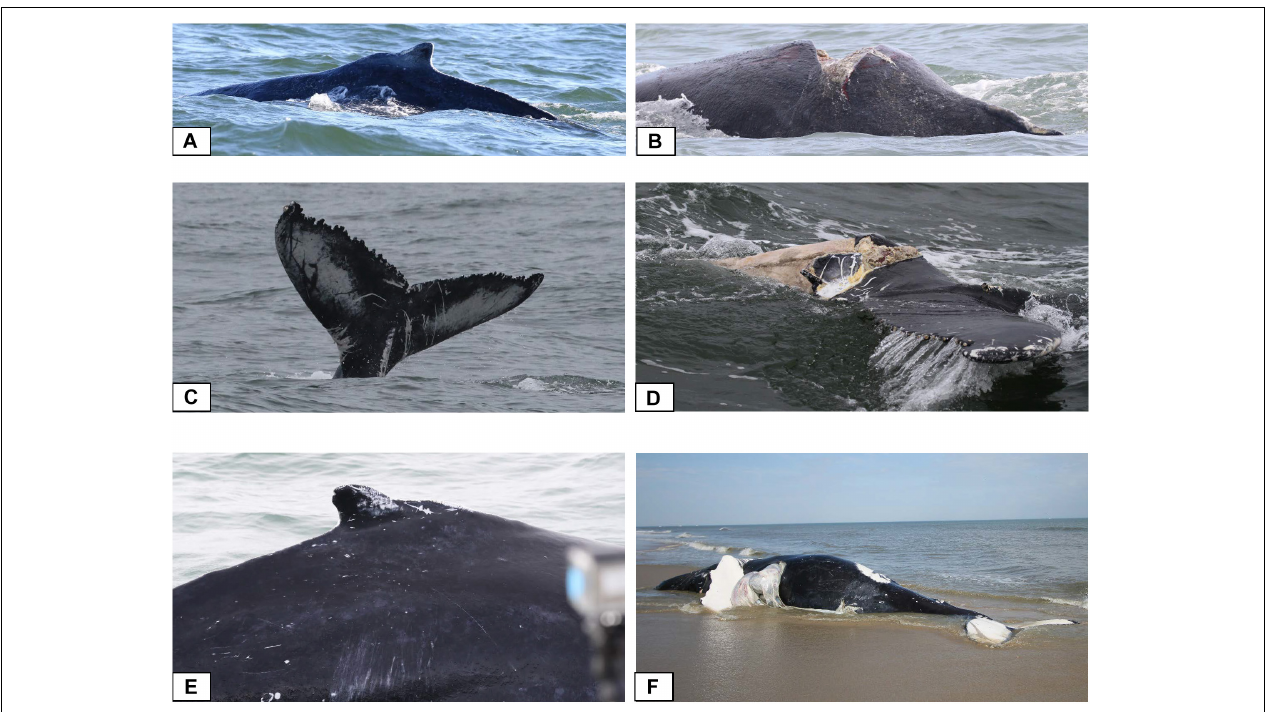
FIGURE 8 | (A) Humpback whale observed January 02, 2016 with no apparent injuries, and (B) again on January 09, 2016 with severe laceration across its back; (C) humpback whale observed fluking on Decmber 30, 2015 without injury, and (D) again on March 03, 2016 with nearly severed tail fluke; (E) humpback whale photographed and tagged on January 11, 2017, and (F) dead on a Virginia Beach with large incisions and exposed organs on February 12,